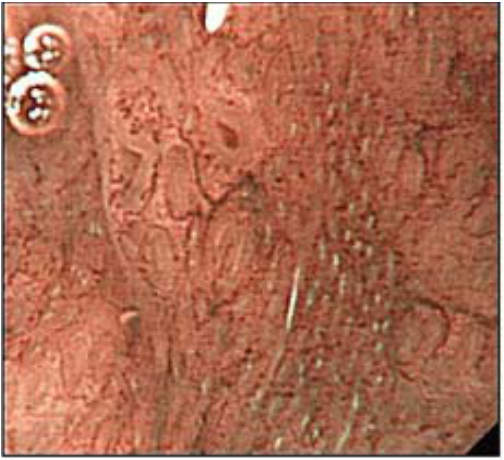
FIGURE 16. Duodenum: Gluten enteropathy with complete villous atrophy; narrow- band imaging coupled to magnification. The surface of the mucosa is smooth and the vascular network, colored in dark brown is